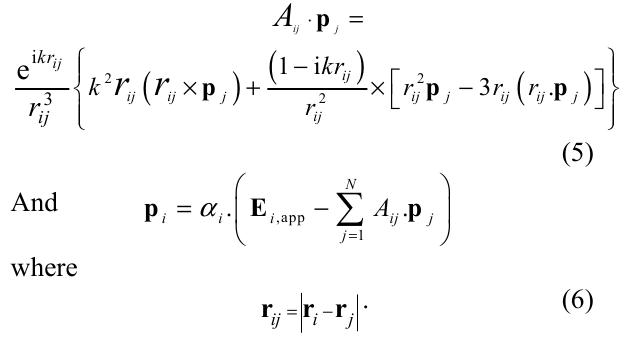
Fig. 1 Illustration of the triangular prism